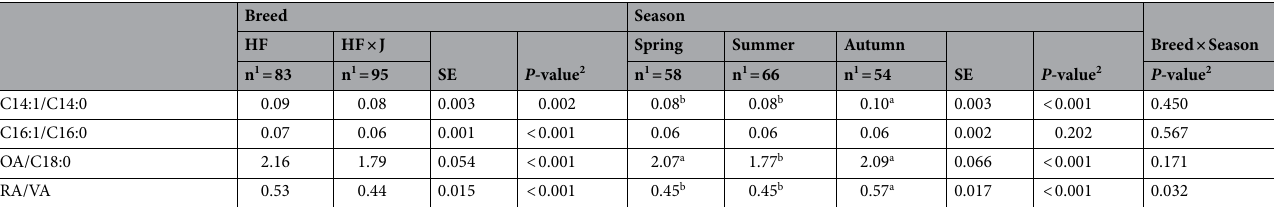
Table 3. Means ± SE and P -values for breed and season on the fatty acid profile of milk collected from 73 individual cows from two breeding groups (100% Holstein-Friesian, HF; 50% Holstein-Friesian:50% Jersey, HF × J) and different seasons in four low-input dairy farms in England and Wales. 1 n is the number of records used to calculate means. 2 Significances were declared at P < 0.05. Means within a row, for season, with different upper-case letters are significantly different according to Fisher’s protected least significant difference test ( P < 0.05). 3 SFA: C4:0, C5:0, C6:0, C7:0, C8:0, C9:0, C10:0, C11:0, C12:0, C13:0, C14:0,